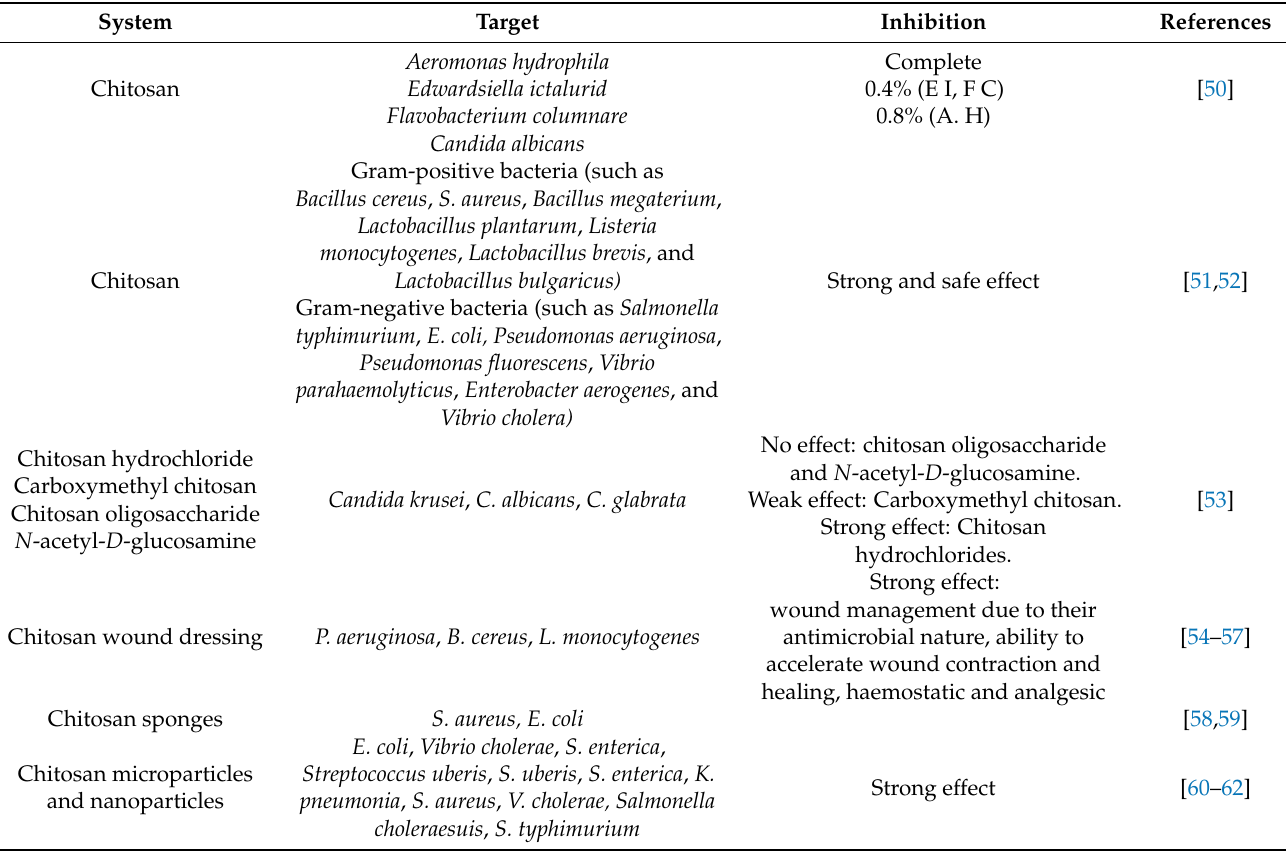
Table 3. Antimicrobial and antifungal activity of